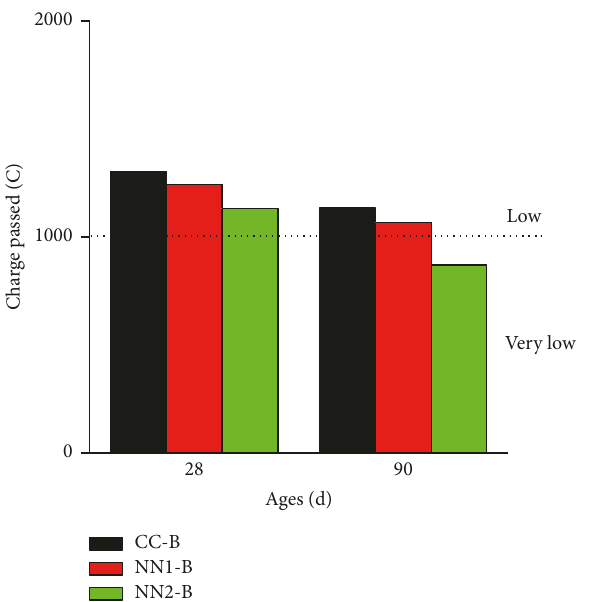
Figure 23: Chloride ion permeability of the standard-cured con- crete with W/B of 0.32.